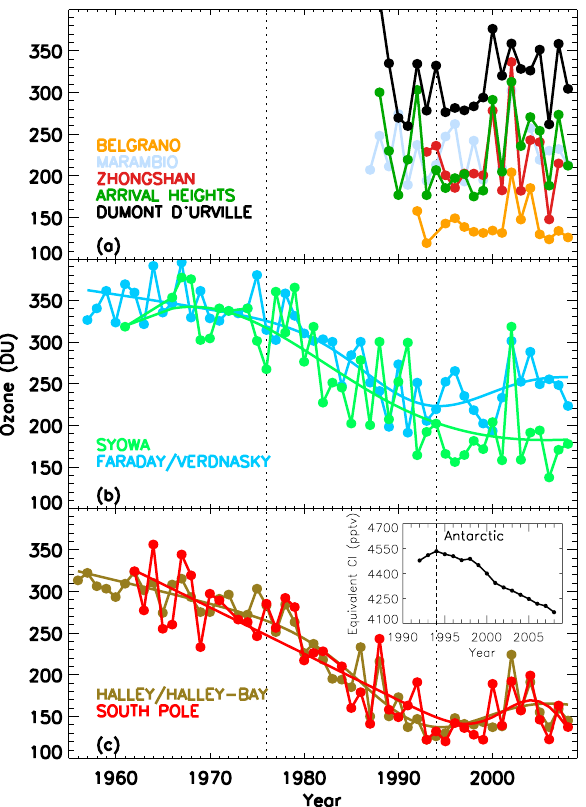
Fig. 8. Evolution of October mean total ozone in the Antarctic from ground-based observations. (a) Stations installed after 1985, (b) historical stations Syowa and Faraday, and (c) historical stations South Pole and Halley and the equivalent chlorine in the Antarctic in the inset. The historical data are plotted separately for clarity reasons. The dotted vertical lines represent years 1976 and 1994. A Gaussian fit is shown in the time series of the historical stations.